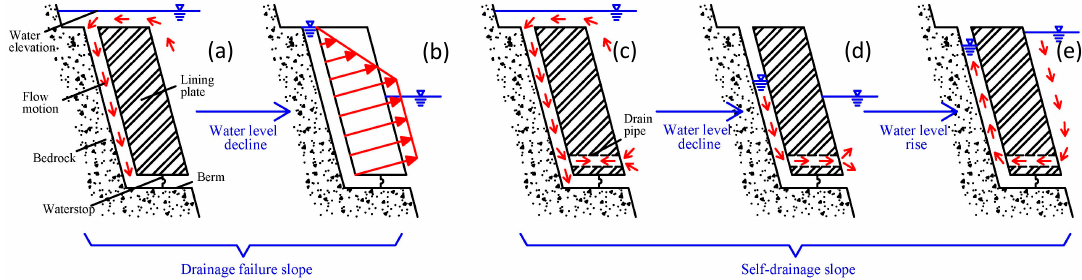
Figure 10. Motion of the flow inside the cracks between the lining plates and the bedrock. ( a ) drainage failure plate with high water level in plunge pool; ( b ) drainage failure plate with sudden drop of water level in plunge pool; ( c ) self-drainage plate with high water level in plunge pool; ( d ) self-drainage plate with sudden drop of water level in plunge pool; and ( e ) self-drainage plate with sudden rise of water level in plunge pool.